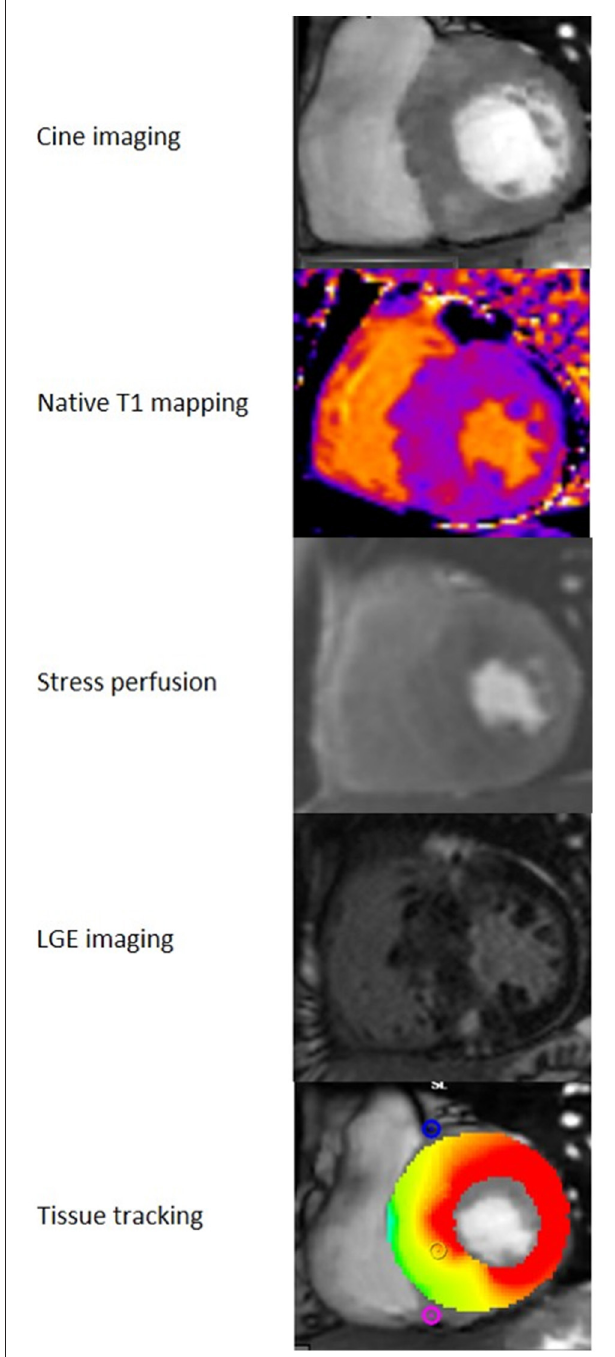
FIGURE 2 | CMR analysis. CMR images from a patient with HCM. Note the asymmetrical septal hypertrophy in the cine images, perfusion defects in the most hypertrophied segments in the stress perfusion acquisition and midwall LGE in the septum and right ventricle insertion points. and more extensive LGE and increased the risk of AF/AFL.